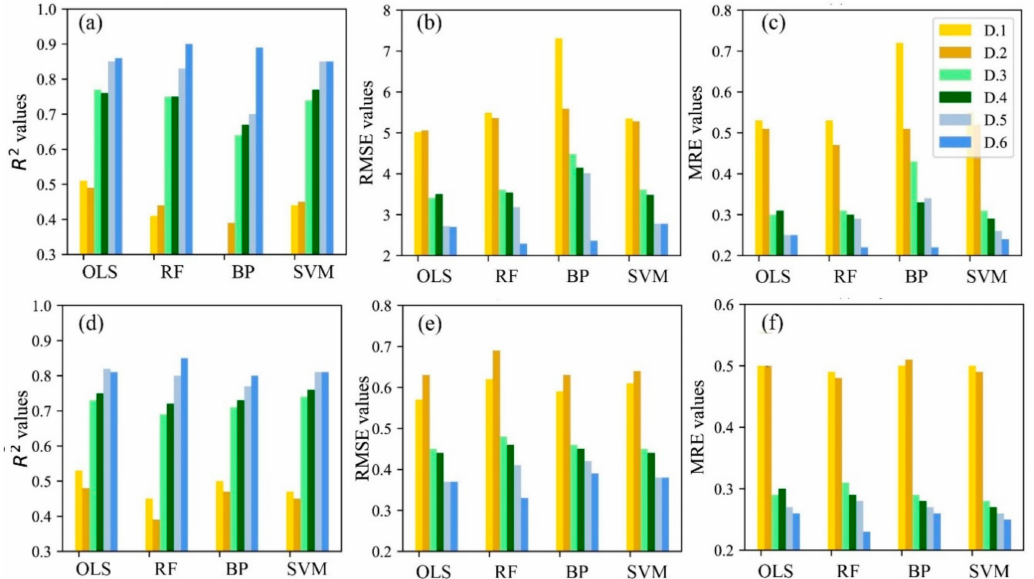
Figure 11. Comparison of the accuracy of AGB estimation for the four methods using Dataset 1 (multiSPEC-4C—five variables), Dataset 2 (multiSPEC-4C—T 10 and mean), Dataset 3 (Micasense RedEdge-M—five variables), Dataset 4 (Micasense RedEdge-M—T 10 and mean), Dataset 5 (LiDAR—five variables), and Dataset 6 (LiDAR—T 10 and mean): ( a ) R 2 , ( b ) RMSE, and ( c ) MRE of the maize fresh AGB estimate; ( d ) R 2 , ( e ) RMSE, and ( f ) MRE of the maize dry AGB estimate. (D.1 represents Dataset